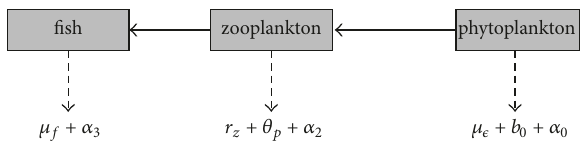
Figure 1: Typical ecological situation presented by food-chain